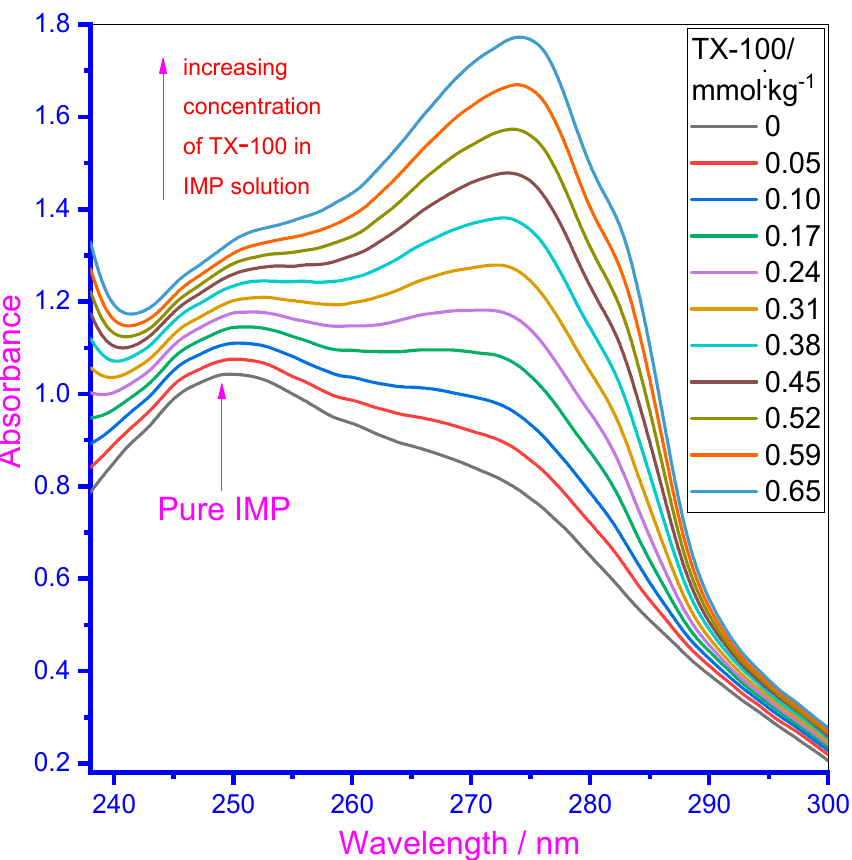
Figure 4. UV–Visible spectra of the drug in the absence along with the existence of a growing concentration of TX-100.